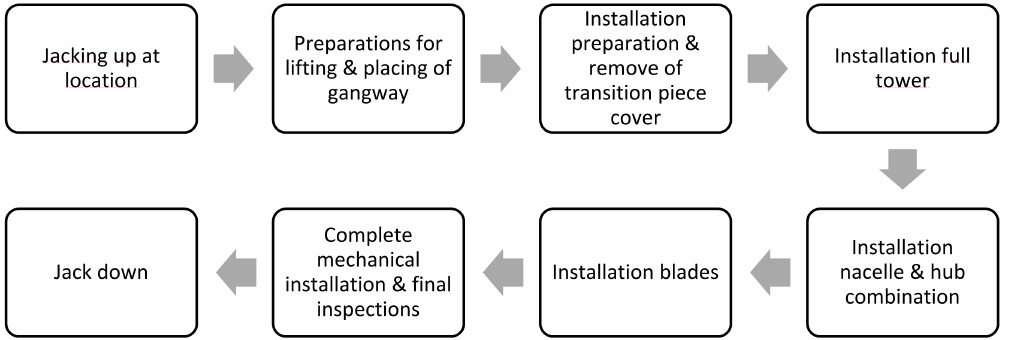
Figure 6. The installation process of an offshore wind turbine.